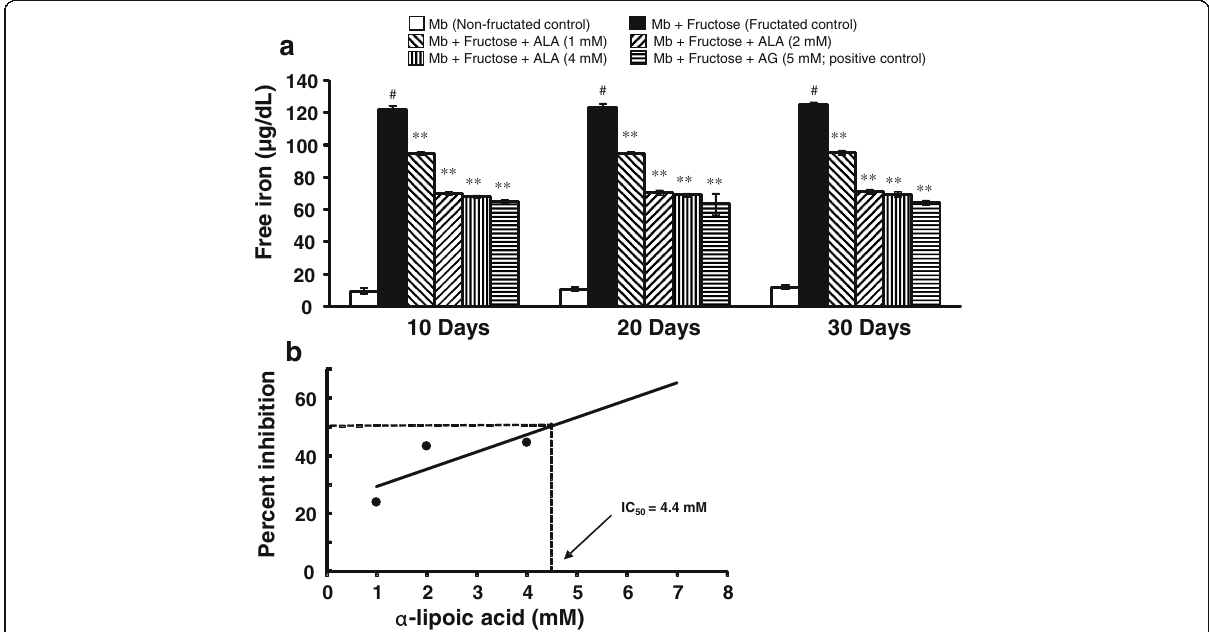
Fig. 2 Effects of α -lipoic acid on free iron release in fructose-induced myoglobin fructation. Each bar represents the mean ± SEM in six separate experiments (n = 6). Significant difference compared to fructated control at identical times: ** p < 0.01. Significant difference from non-fructated control: # p < 0.001. ALA = α -lipoic acid; AG = Aminoguanidine; Mb =